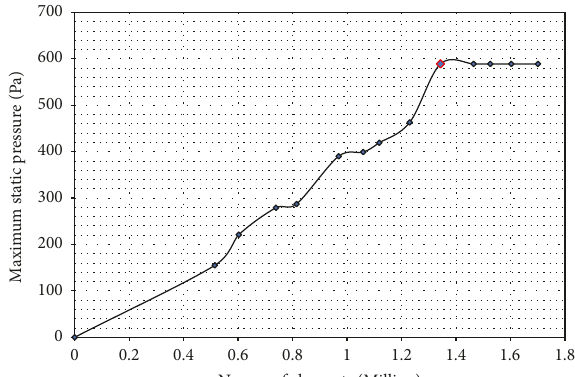
Figure 4: Mesh sensitivity